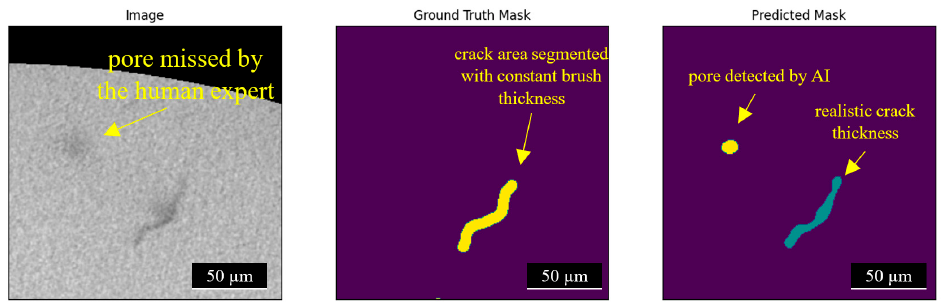
Figure 16. AI outperforming human expert (ground truth mask) during training.